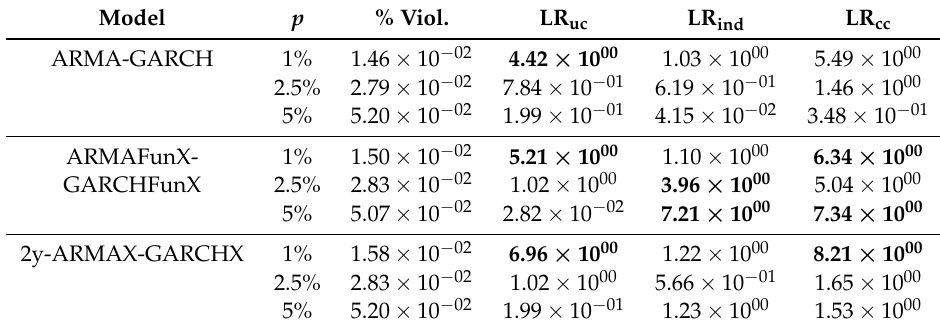
VaR prediction performance with a window size of 500 days for ARMA-GARCH, ARMAFunX-GARCHFunX and 2y-ARMAX-GARCHX for 1 − p ∈ { 99%,97.5%,95% } . Bold numbers denote significant values at the